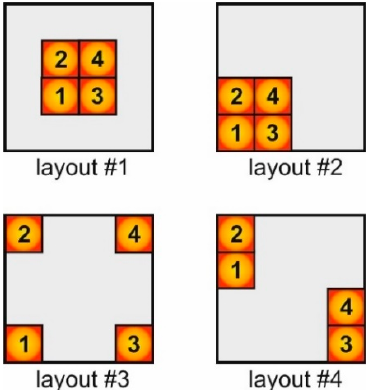
Figure 12. ( a ) Comparison between TRIC and FloTHERM for various eTQFP cases; ( b ) corresponding percentage error vs. time.